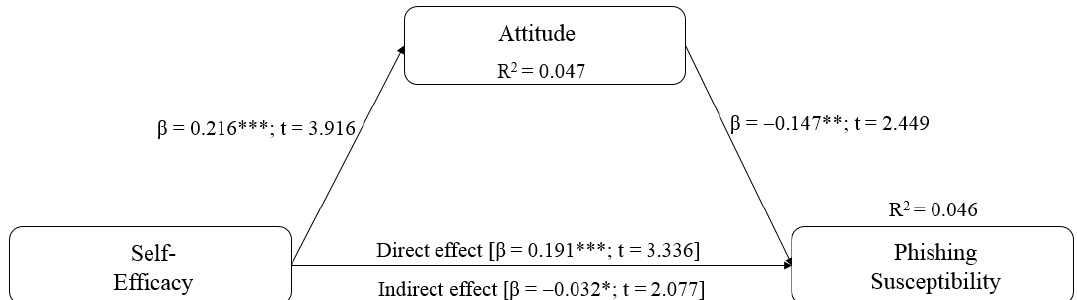
Figure 3. Research framework’s structural analysis results. Note: *** = p < 0.001, ** = p < 0.01, * = p < 0.05.